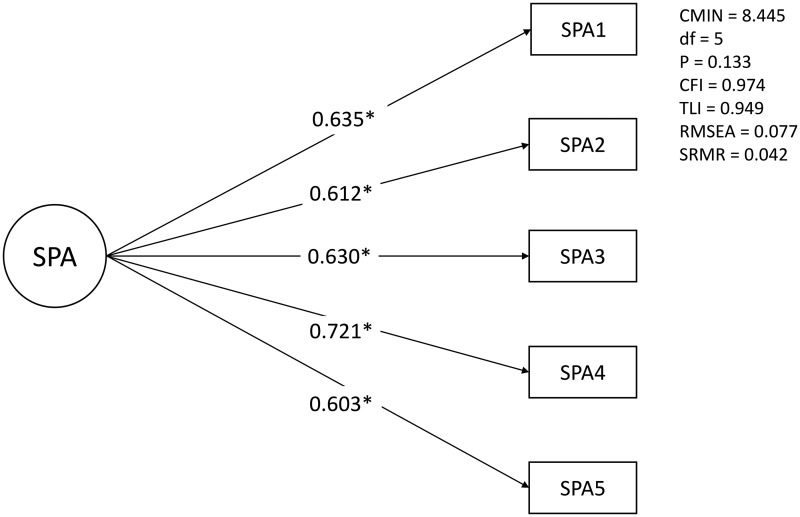
Results of confirmatory factor analysis.